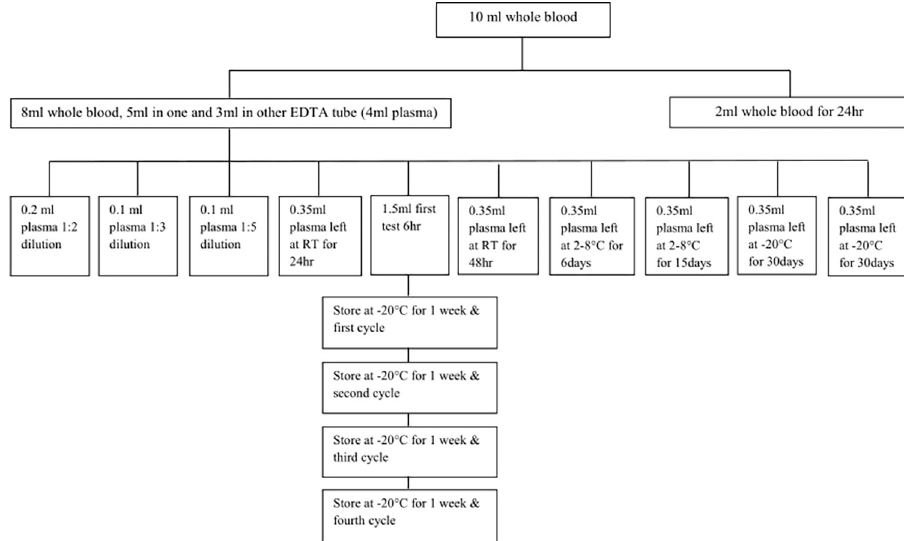
Fig 2. Sample allocation flow chart for each